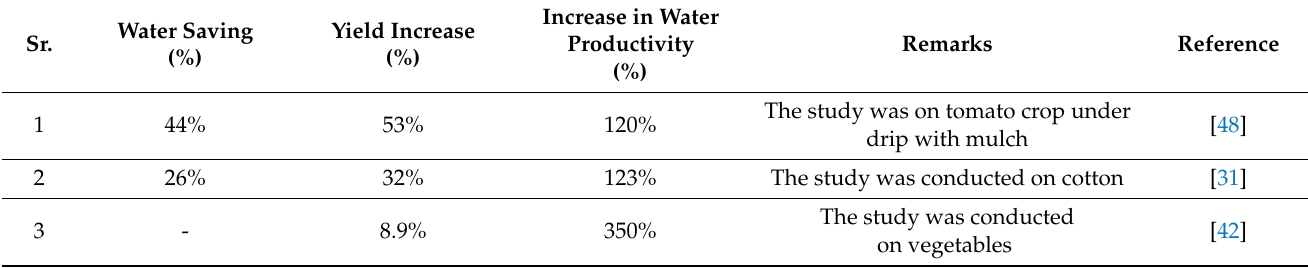
Table 3. Water saving, yield increase, and water productivity improvement under high-efficiency irrigation